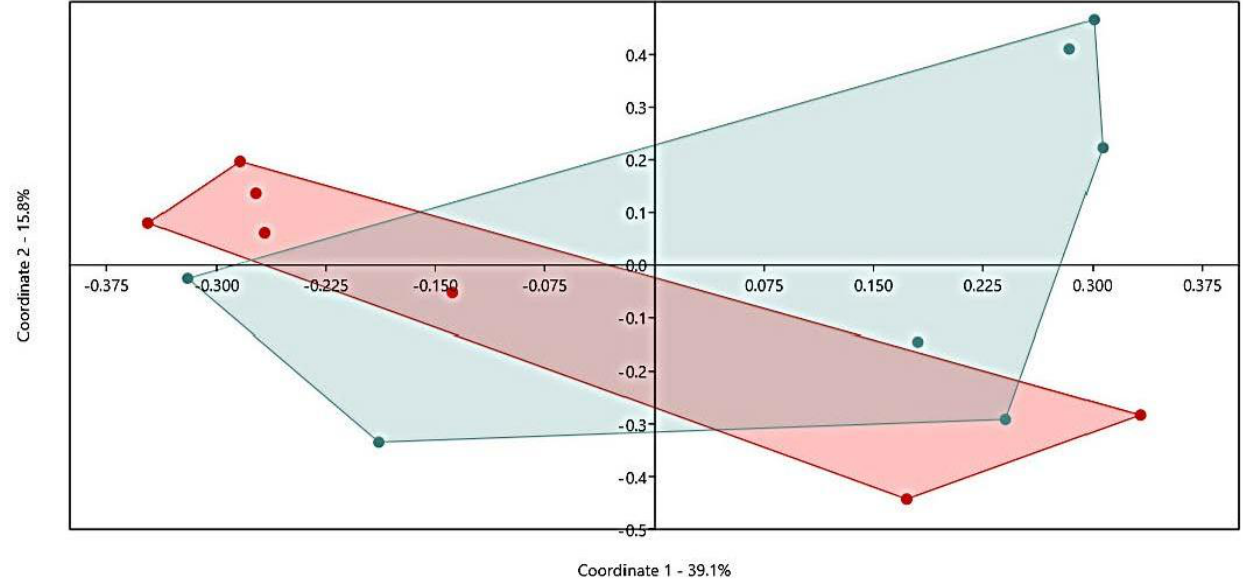
Figure 2. Principal coordinate analysis (PCoA) defining the relationship between samples based on the bacteria operational taxonomic unit (OTU) level. Colors represent different CH 4 groups: green= low emitters, and red = high emitters. Axes describe percentage of variance.